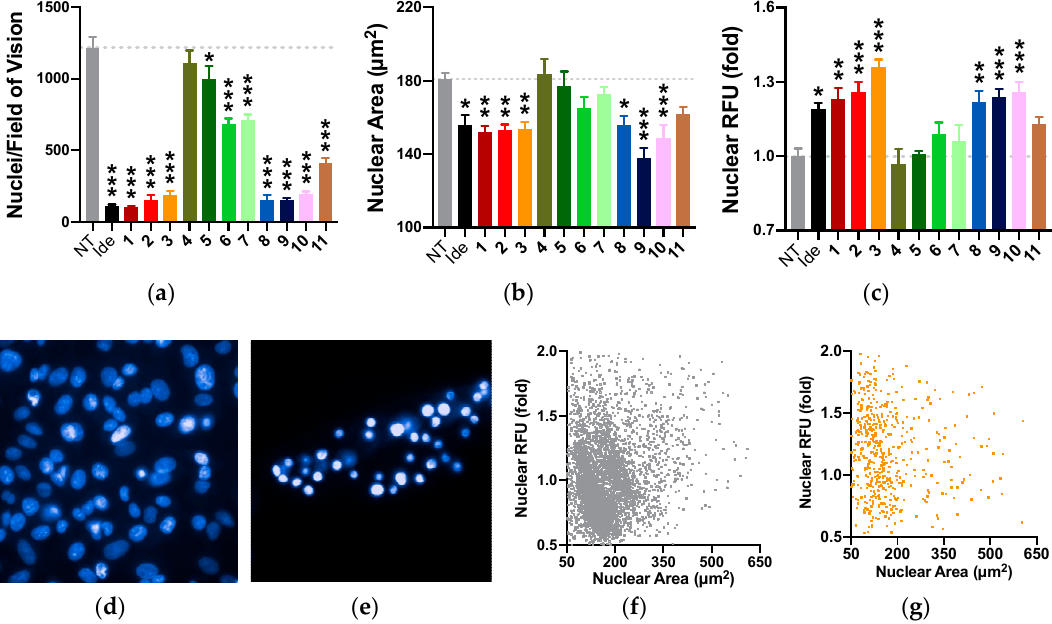
Figure 5. Effect of test compounds on nuclear count and morphology. Cells were exposed to reference or test compounds (100 μ M) for 24 h before ( a ) nuclear count, ( b ) area, and ( c ) intensity were assessed. Exemplary fluorescence images (60 × magnification) of ( d ) non-treated (NT) and ( e ) treated DAPI- stained nuclei; single cell plots of nuclei either ( f ) NT or ( g ) treated with compound 3 are presented. Compound 3 ( e , g ) significantly reduced average nuclear count and size, and increased average fluorescence intensity than NT ( d , f ). Nuclear RFU was standardized on the average intensity of NT control nuclei and expressed as fold-change. Data represents mean ± SEM of 8 independent images per treatment. Two-way ANOVA was performed to compare idebenone or test compounds against the non-treated control: *** p < 0.001, ** p < 0.002, * p < 0.033.